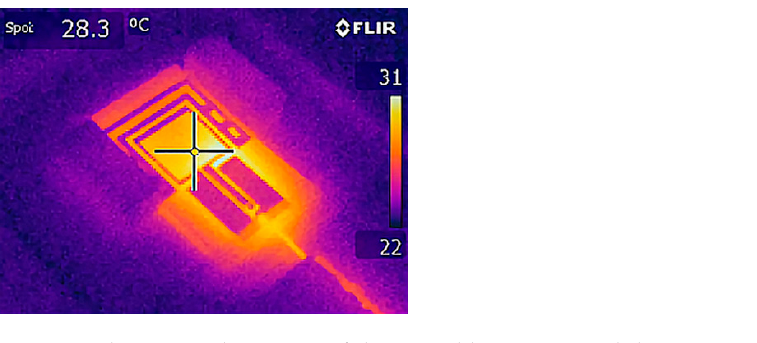
Figure 3. Thermographic image of the wearable antenna and the two cuvettes with erythrocyte sus- pensions immediately after EMF